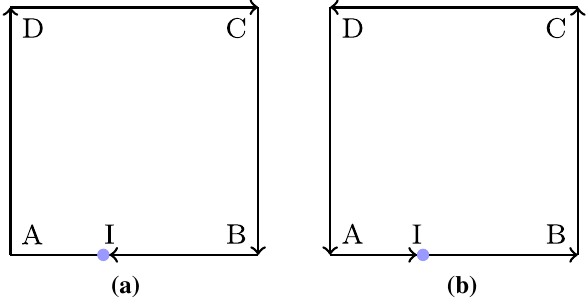
Fig. 3 As seen from lab frame: a clockwise, b counter-clockwise